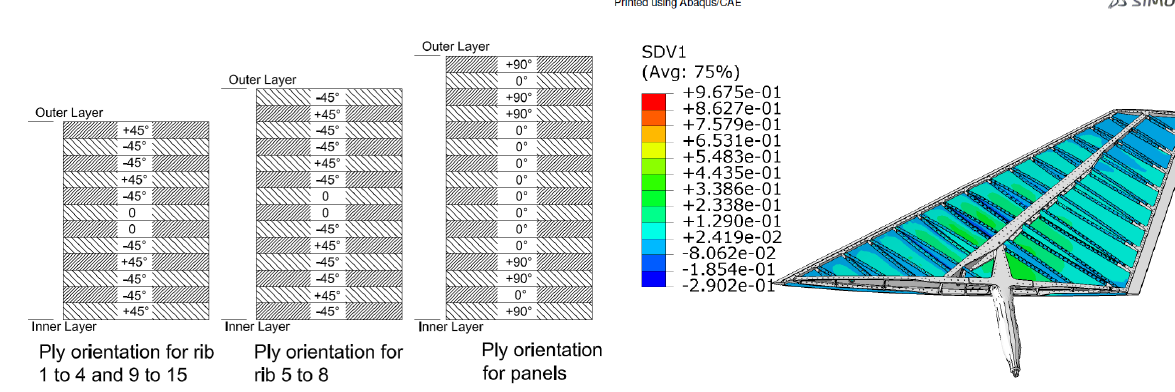
Figure 3: CFC Canard (a) Ply orientations (b) FI Index Plot